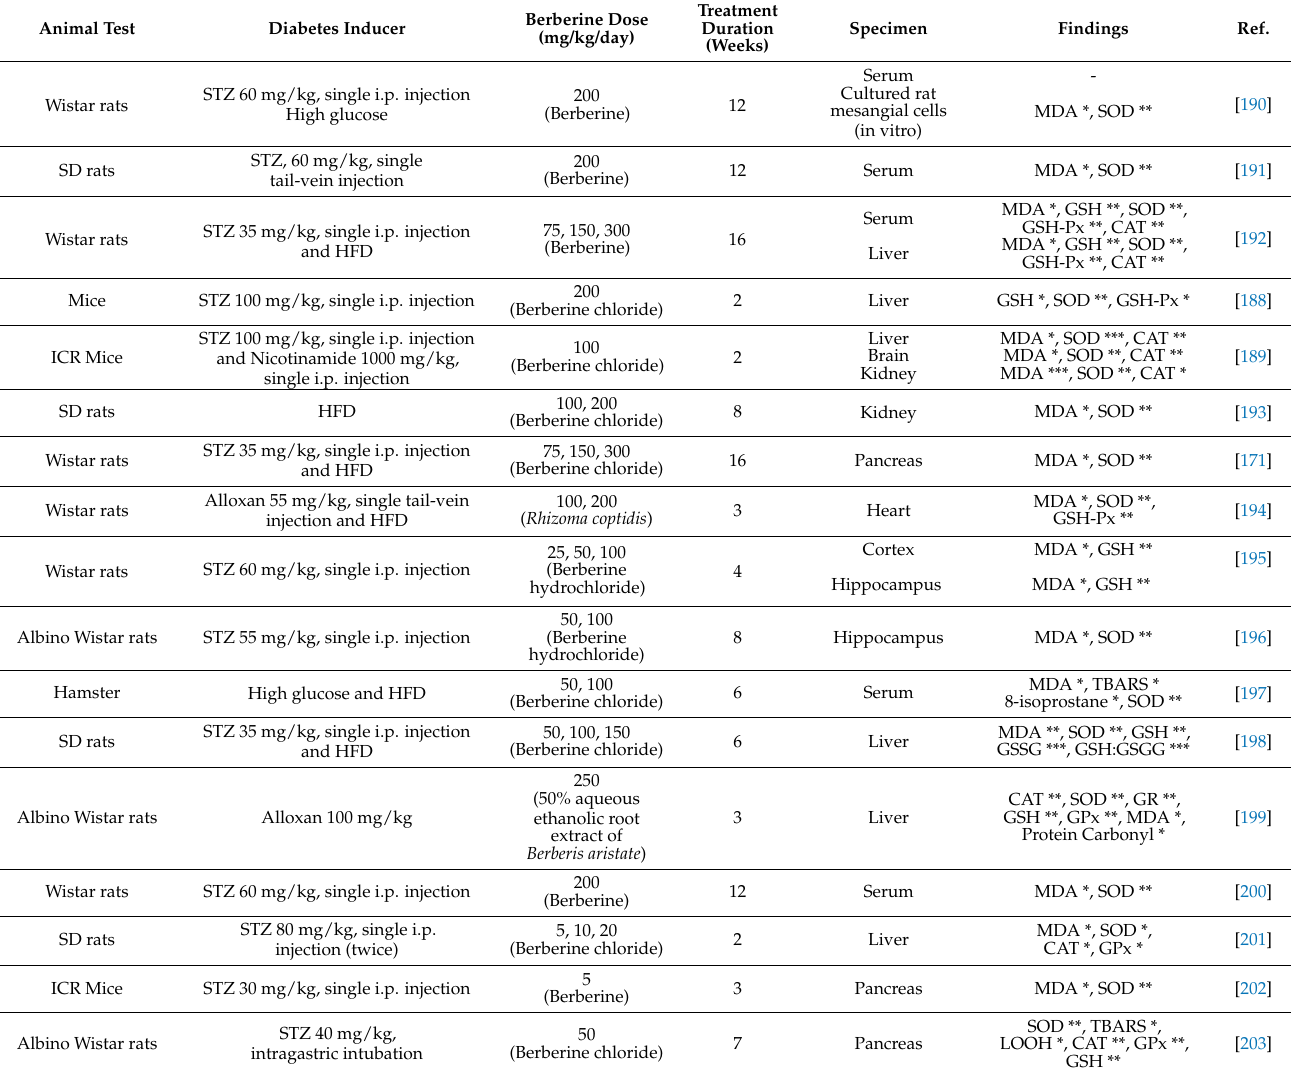
Table 3. Effect of berberine on antioxidant parameters in diabetic animal